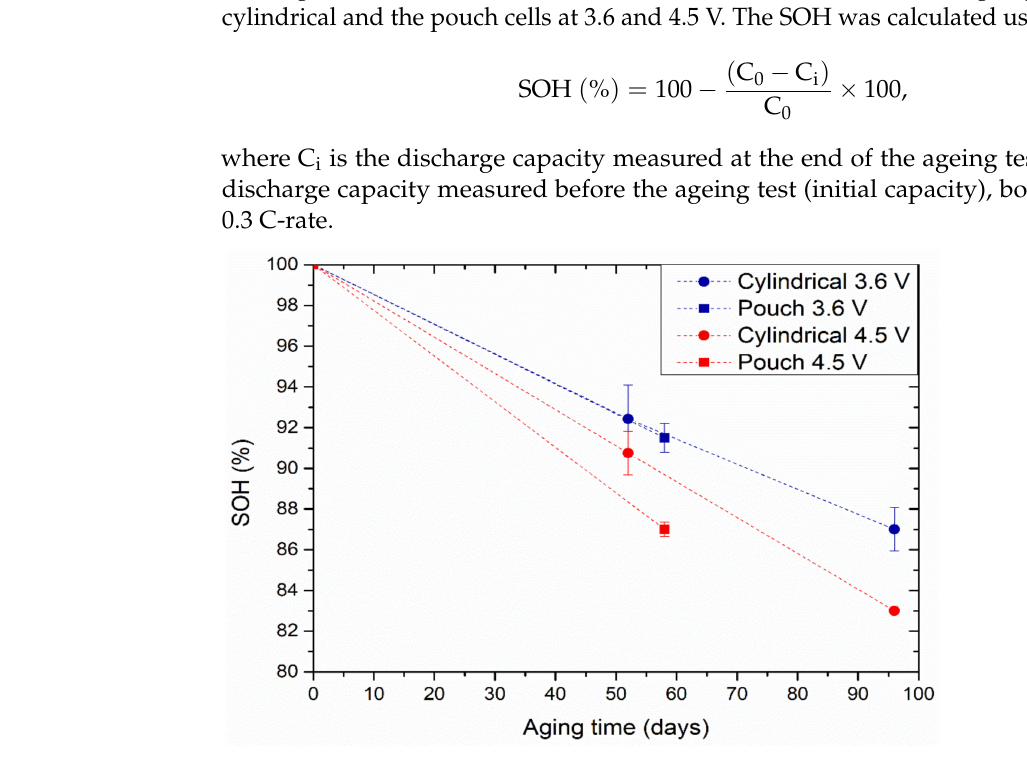
Figure 2. SOH evolution upon calendar aging at 25 ◦ C for cylindrical (circles) and pouch (squares) cells at 3.6 V (blue markers) and 4.5 V (red markers). Error bars indicate the standard deviation between the two cells per